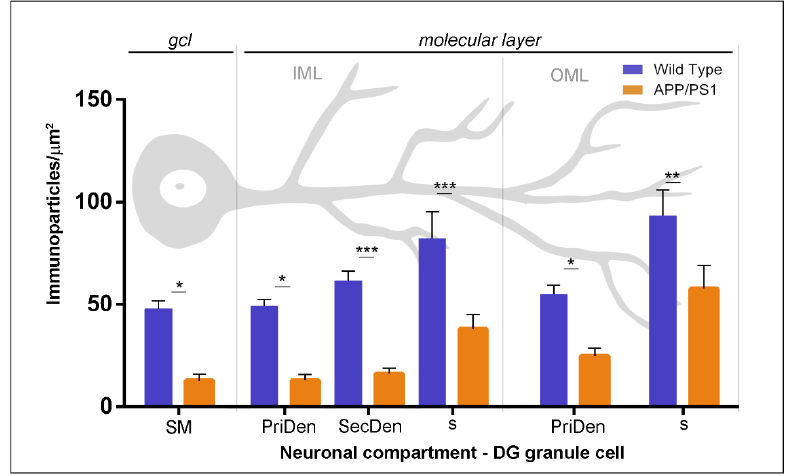
Figure 4. Density gradient of GABA B1 immunoparticles along the surface of granule cells in wild type and APP / PS1 mice at 12 months. Quantitative analysis of GABA B1 immunogold labelling in six neuronal compartments of DG granule cells. The density gradient of immunoparticles for GABA B1 along the neuronal surface was significantly reduced in all subfields and compartments of granule cells analysed in the APP / PS1 mice compared to age-matched wild type (Two-way ANOVA test F (1,192) = 70.78, p < 0.0001 (genotype) and Bonferroni post-hoc test, * p < 0.05; ** p < 0.01; *** p < 0.001). Error bars indicate SEM. Abbreviations: PriDen, primary dendrite; SecDen, secondary dendrite; s, spine; SM,